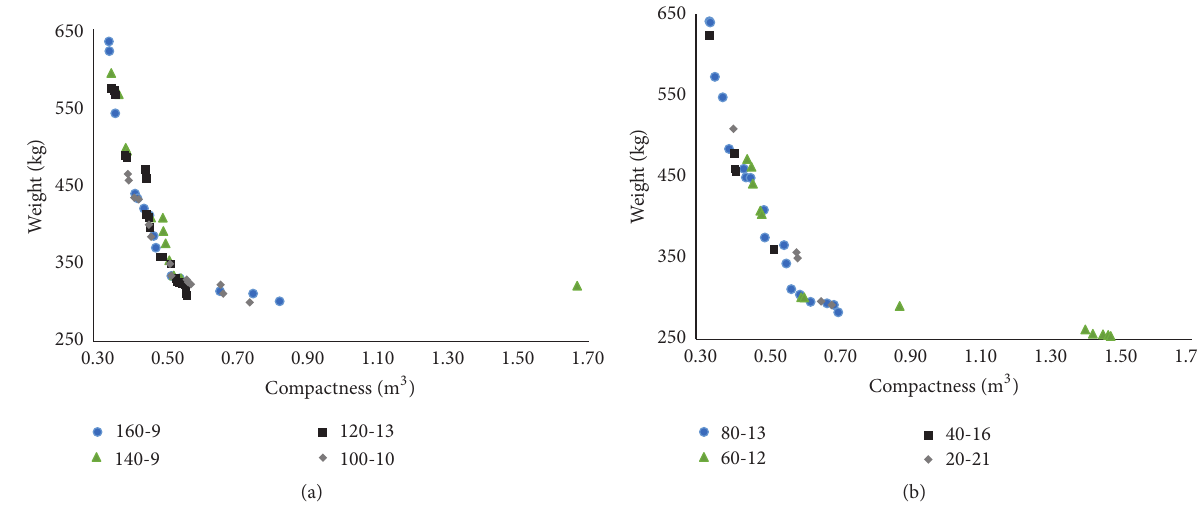
Figure 10: The Pareto fronts of the simulations with different numbers of individuals per generation show that the high value of the hypervolume of simulations 140-6 and 60-12 is related to the extent of the Pareto front and not to the quality of the latter.